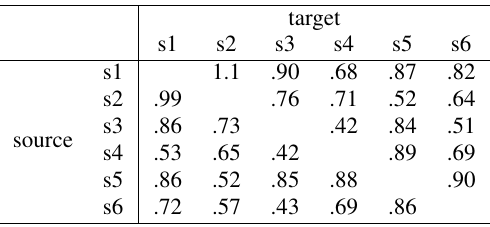
Table 5. Time comparison for Trees dataset